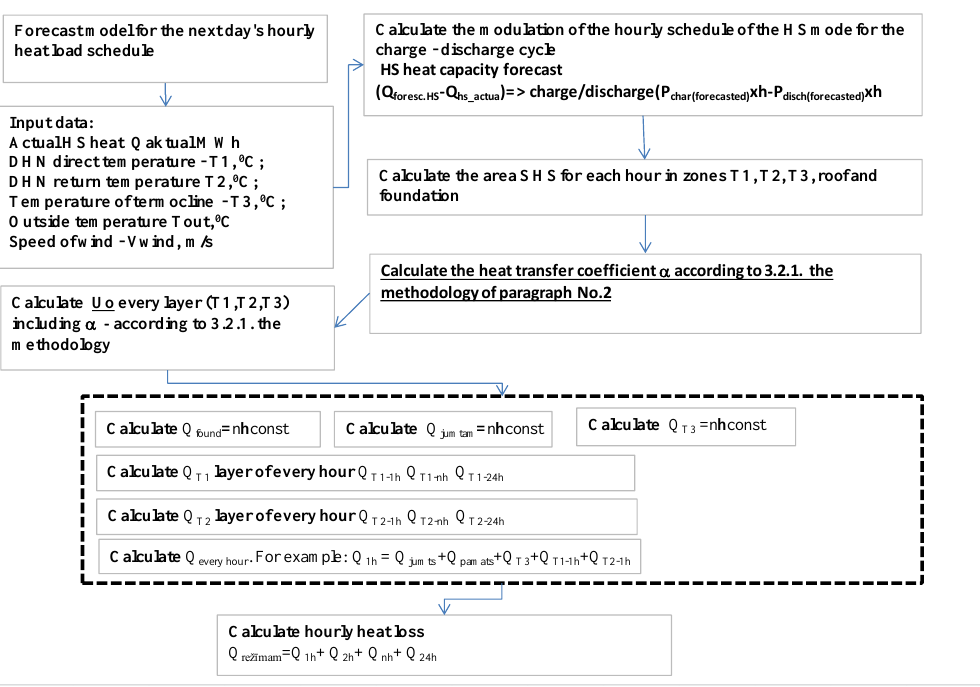
Figure 4. Block scheme which shows the calculation sequence for heat loss in operating